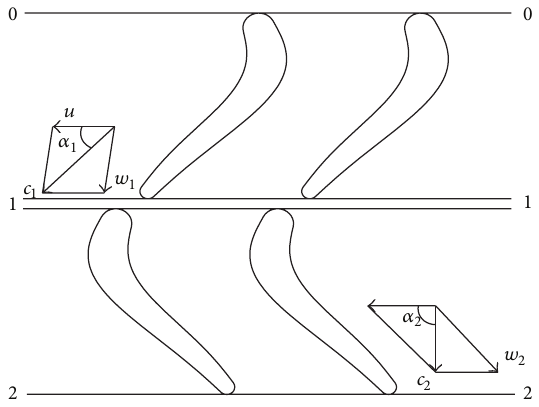
Figure 2: Turbine stage velocity